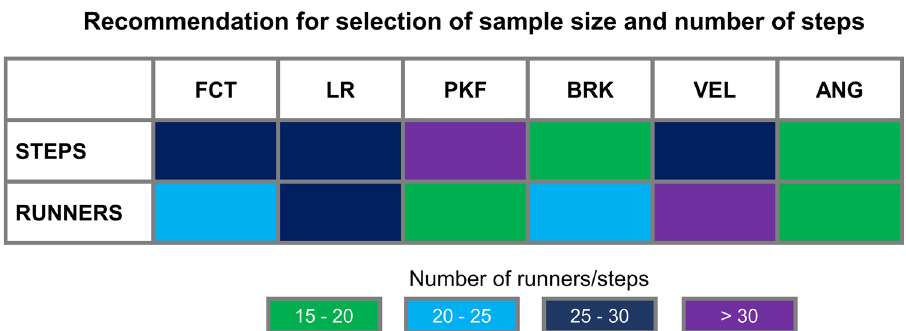
Figure 12. Colormap representing the recommended number of steps and sample size required to achieve individual stable average, as well as reduce variability and maximize effect size. FCT foot contact time, LR loading rate, PKF peak vertical force, BRK peak braking force, VEL running speed, ANG foot contact